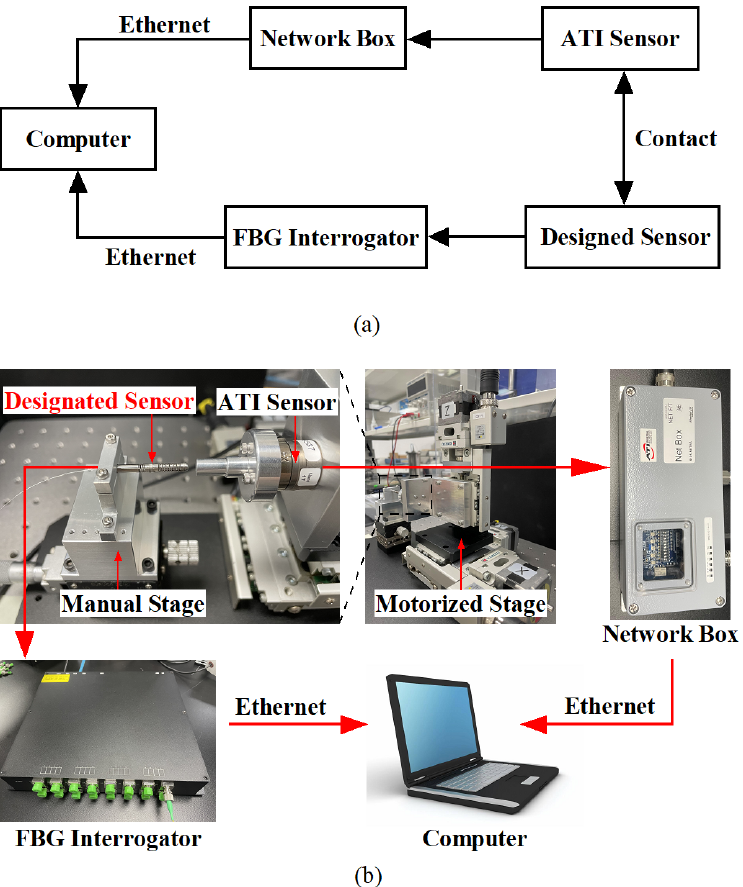
Figure 8. ( a ) Block diagram and usage flow of each equipment in the calibration experiment; ( b ) Experi- mental configuration for force calibration.